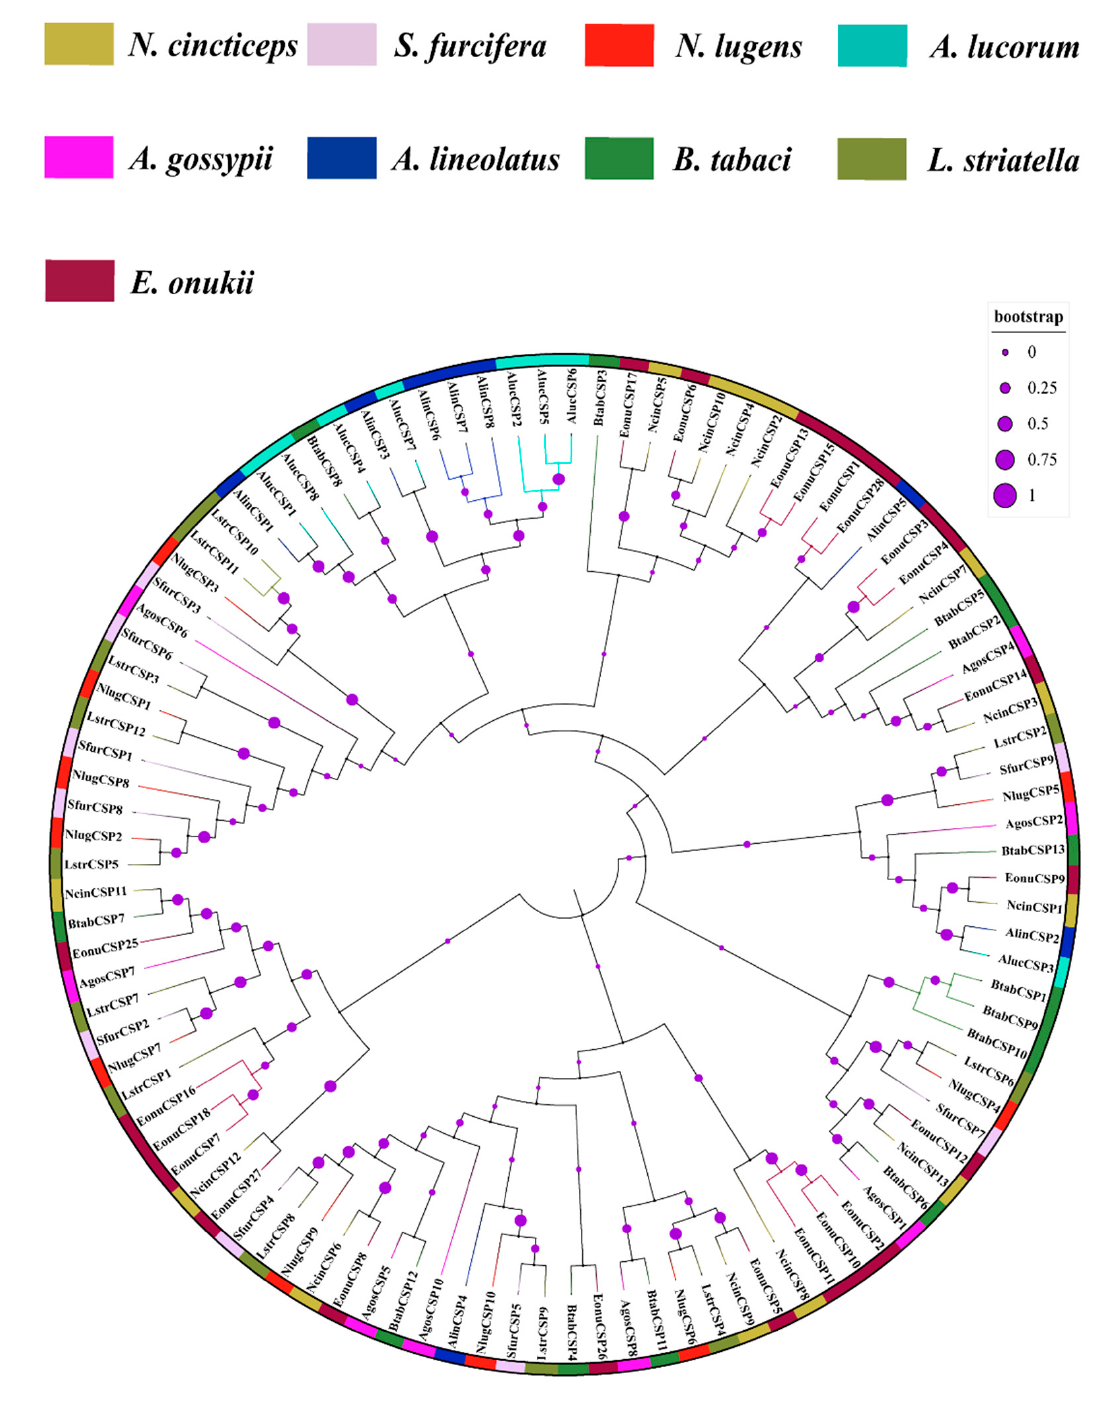
Figure 4. Neighbor-joining tree of 103 CSPs proteins from nine species of Hemiptera. Bootstrap values are shown. The Hemiptera species used to construct the tree are E. onukii , N. lugens , S. furcifera , L. striatella , B. tabaci , A. lucorum , A. lineolatus , A. gossypii and N. cincticeps . The OBP phylogenetic trees were constructed by MEGA 6.0 software with the neighbor-joining method using the Poisson correction distance and 1000 bootstrap replications. The final phylogenetic trees were optimized and visualized by an online tool, iTOL (https://itol.embl.de/ (accessed on 12 March